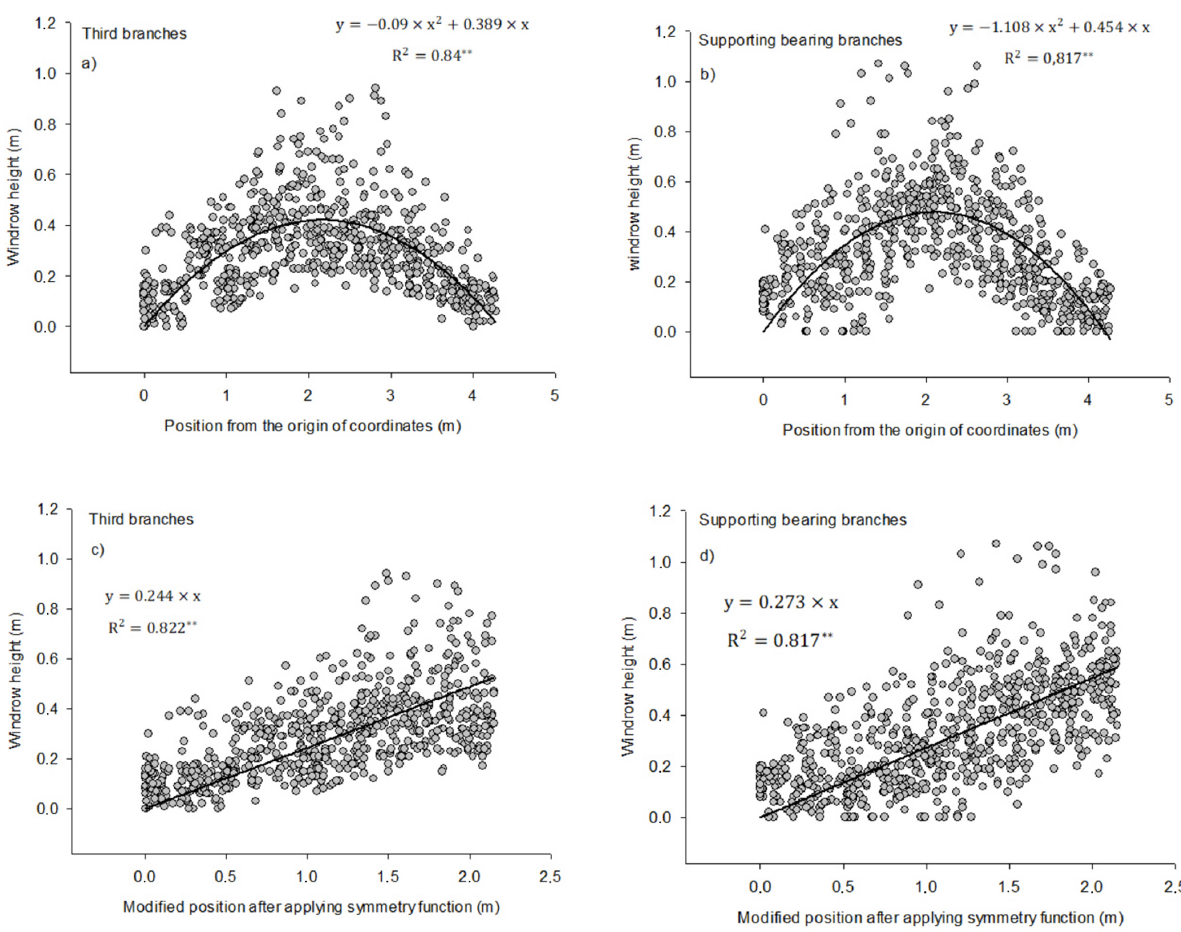
Figure 3. Transversal profile regression functions for the measured windrows using a polynomial function for third branches ( a ) and supporting bearing branches ( b ). In addition, windrow shape was transformed into a linear regression to represent triangular-shaped sections for third branches ( c ) and supporting bearing branches ( d ). Significance level indicated by ** ( p < 0.01). Windrow height was represented by y (vertical axis) and R 2 was coefficient of determination. Table 3. Coefficients and windrow dimensions calculated for manual measurements of pruning windrows depending